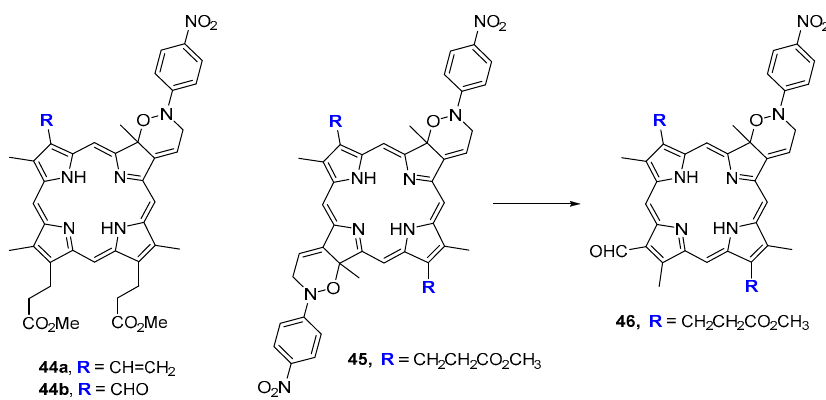
Figure 13. Adducts obtained in the reaction of protoporphyrin-IX and protoporphyrin-II dimethyl esters with p -nitronitrosobenzene [130].